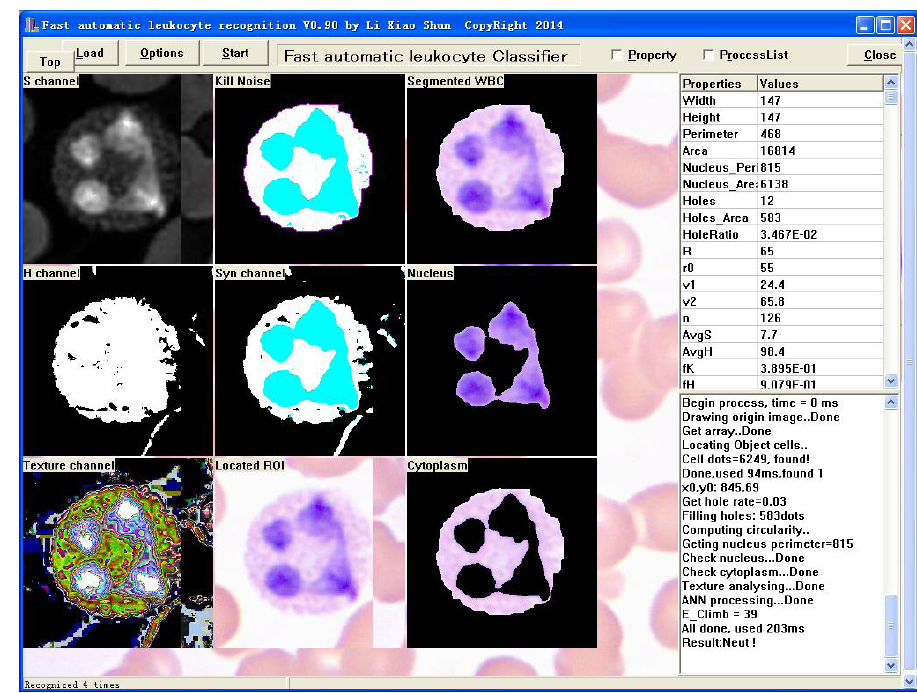
Fig. 15. Software interface: leukocyte